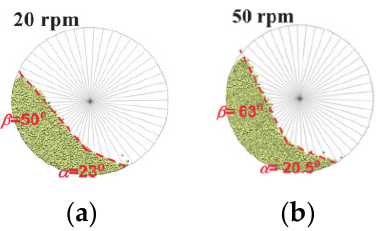
Figure 1. Simulation of dynamic stacking angle ( a ) 20 rpm; ( b ) 50 rpm [57].